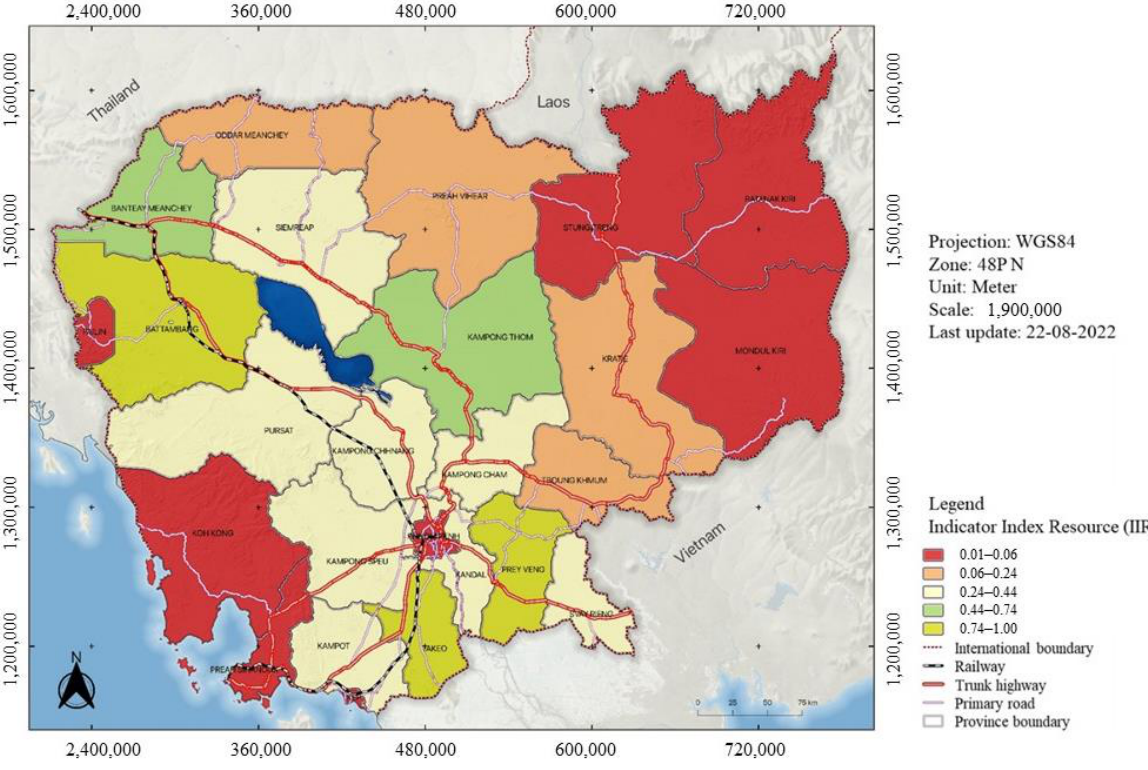
Figure 5. The level of rice straw among provinces in Cambodia.